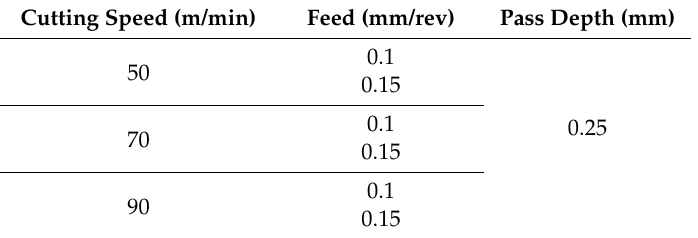
Table 2. Cutting conditions for tool wear